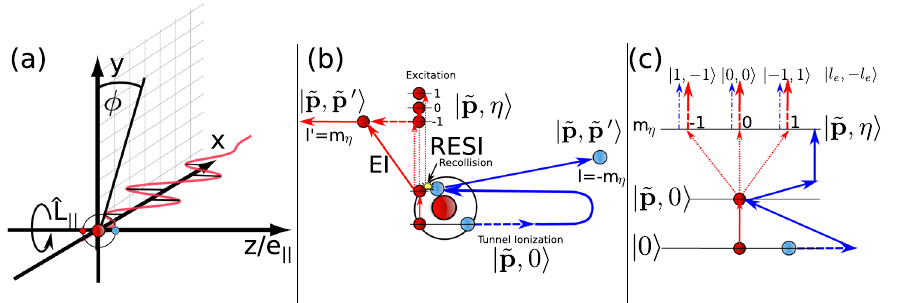
Fig. 1 | Diagram of NSDI and the resulting entanglement of OAM. a Orientation of the linearly polarized laser, with polarization e ∣∣ along the z axis taken for the OAM denoted by ^ L k and the target atom. b NSDI process depicted for the EI and RESI mechanisms. Interaction via the fi eld (e.g. tunnel ionization) is depicted by a dashed line, excitation in the singly charged ion is denoted by dotted lines, while the recollision and OAM sharing is denoted by the yellow spark. The two electron